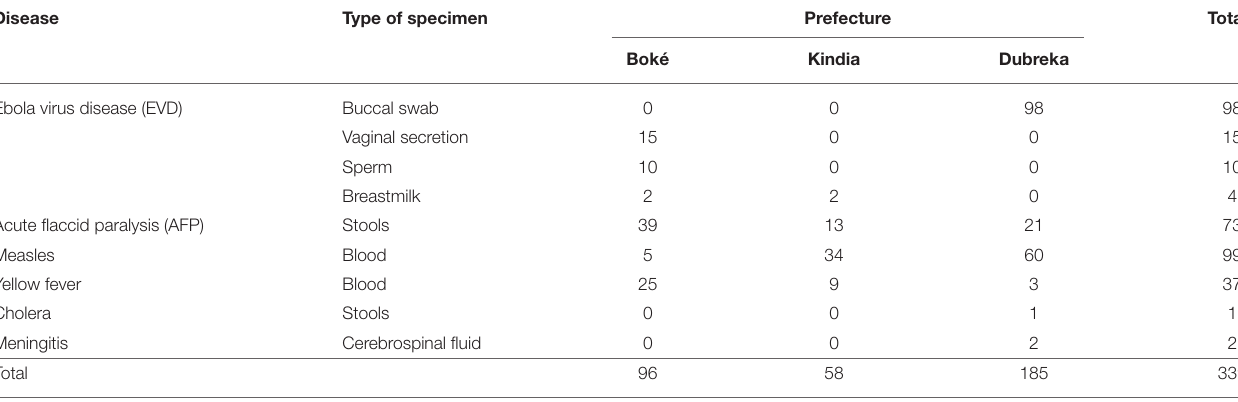
TABLE 2 | Number of specimens transported during the pilot implementation project, by disease and type. Disease